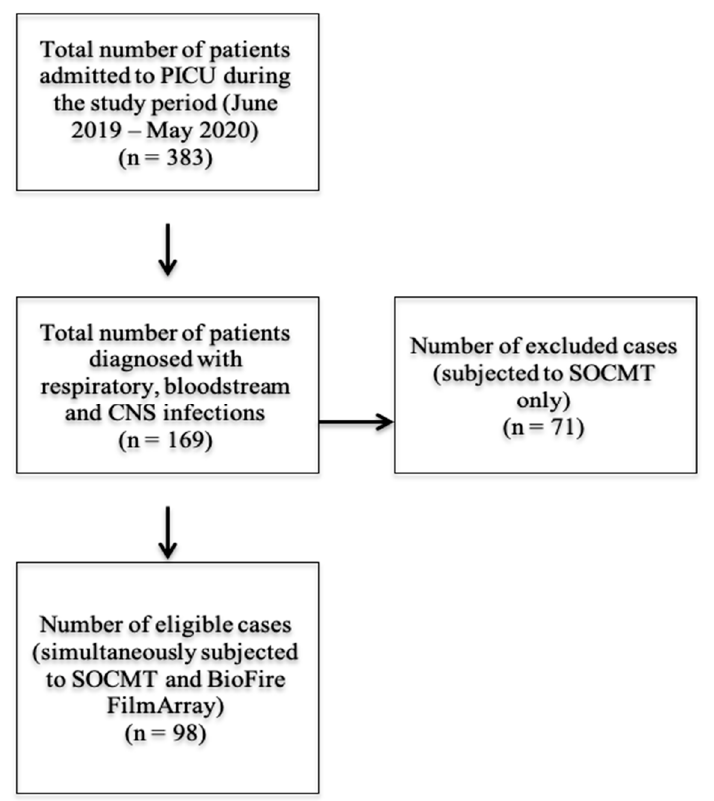
Figure 1. Schematic representation of sample eligibility in the present study.